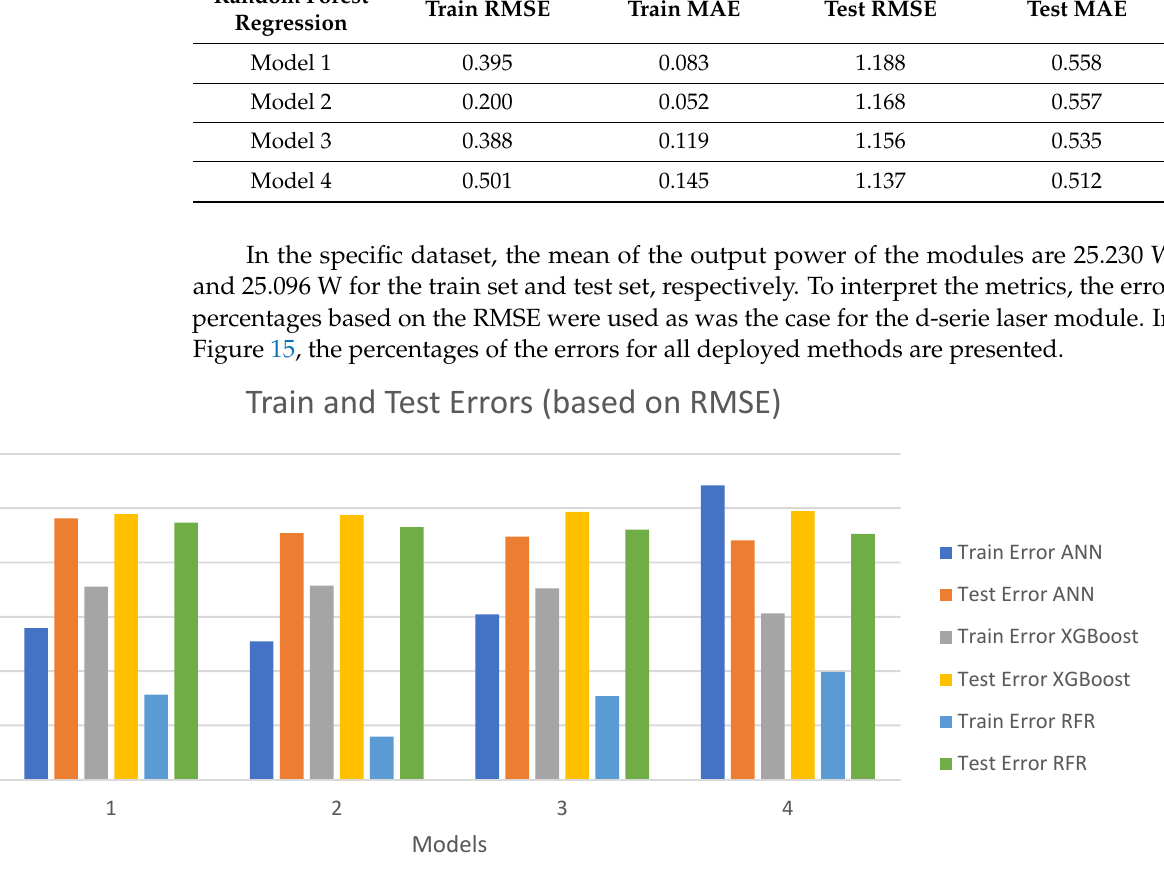
Figure 15. Train and test errors for all prediction methods. Table 11. Train and test RMSE and MAE for all ANN models.